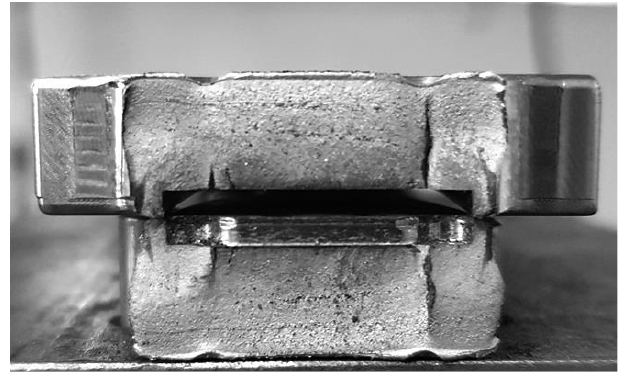
Figure 22. The breaking surfaces of the tested sample.